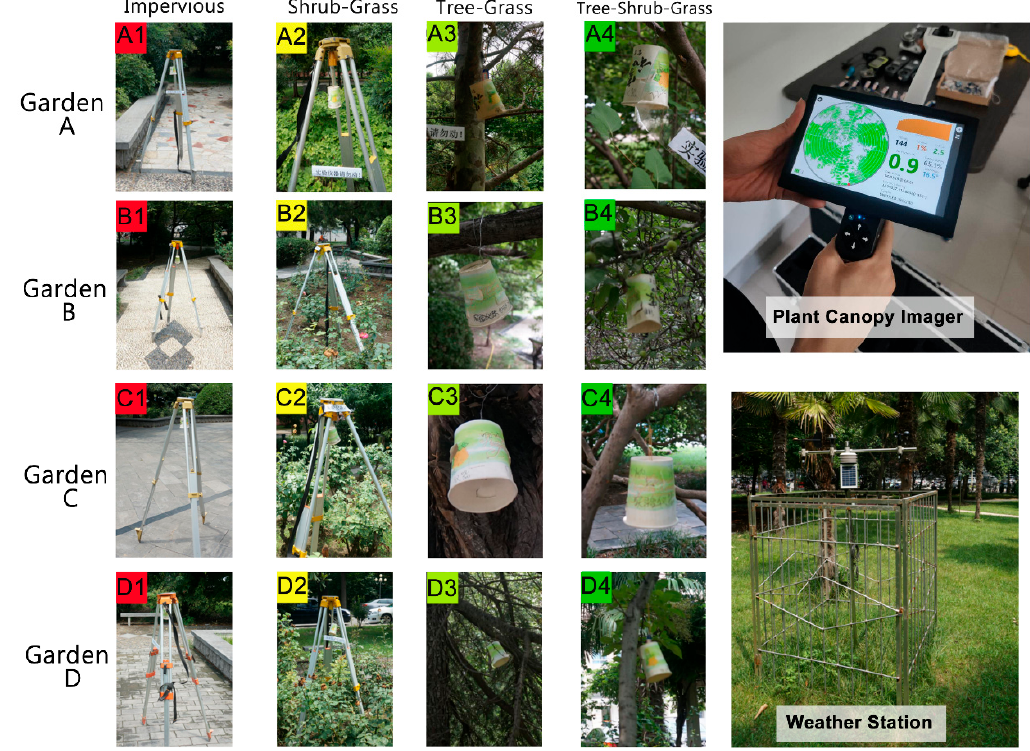
Figure 2. Sixteen measurement points in garden A, B, C, D; Plant canopy imager and weather station used in measurement.